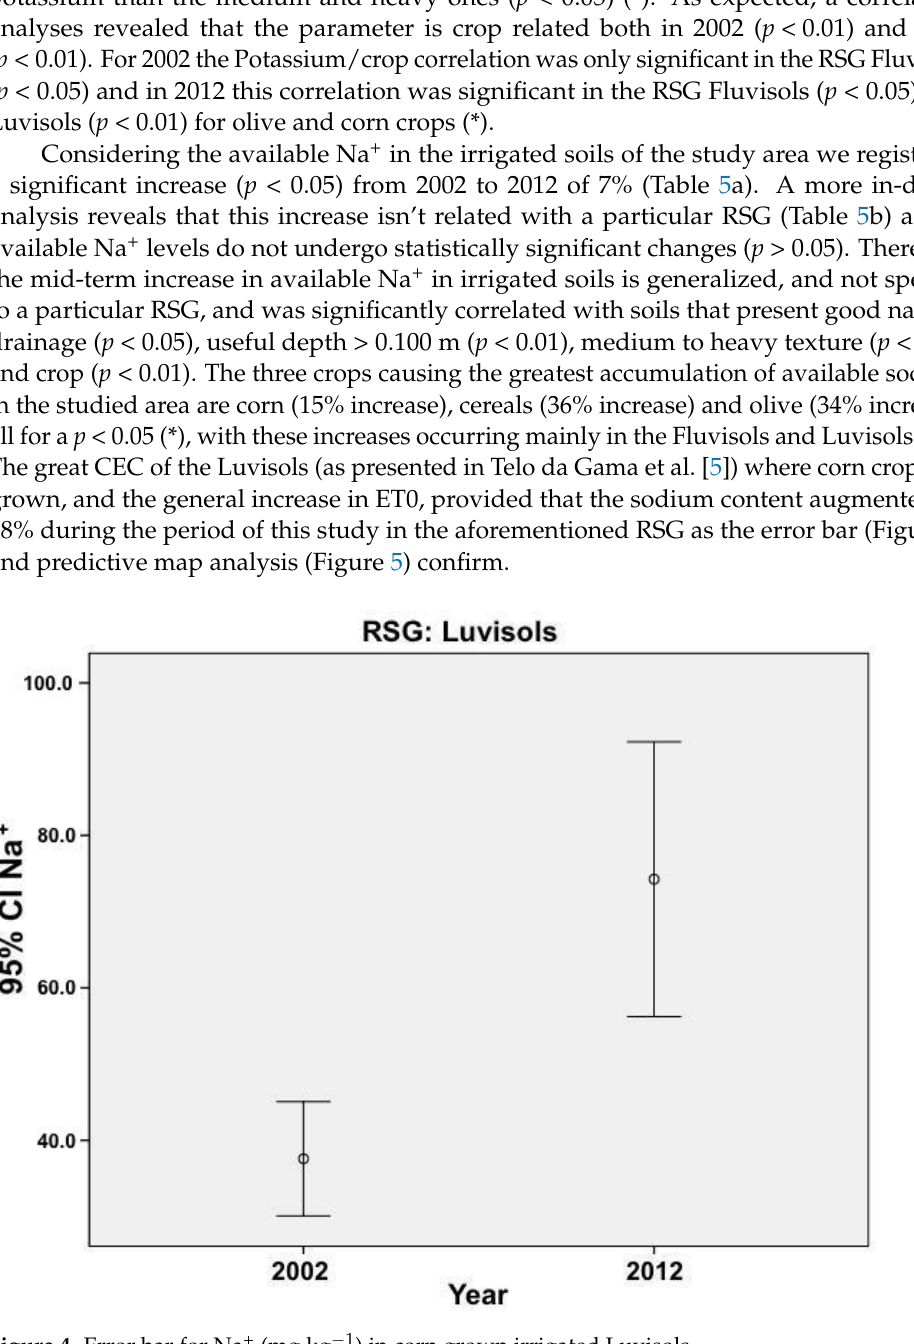
Figure 4. Error bar for Na + (mg kg − 1 ) in corn grown irrigated Luvisols.